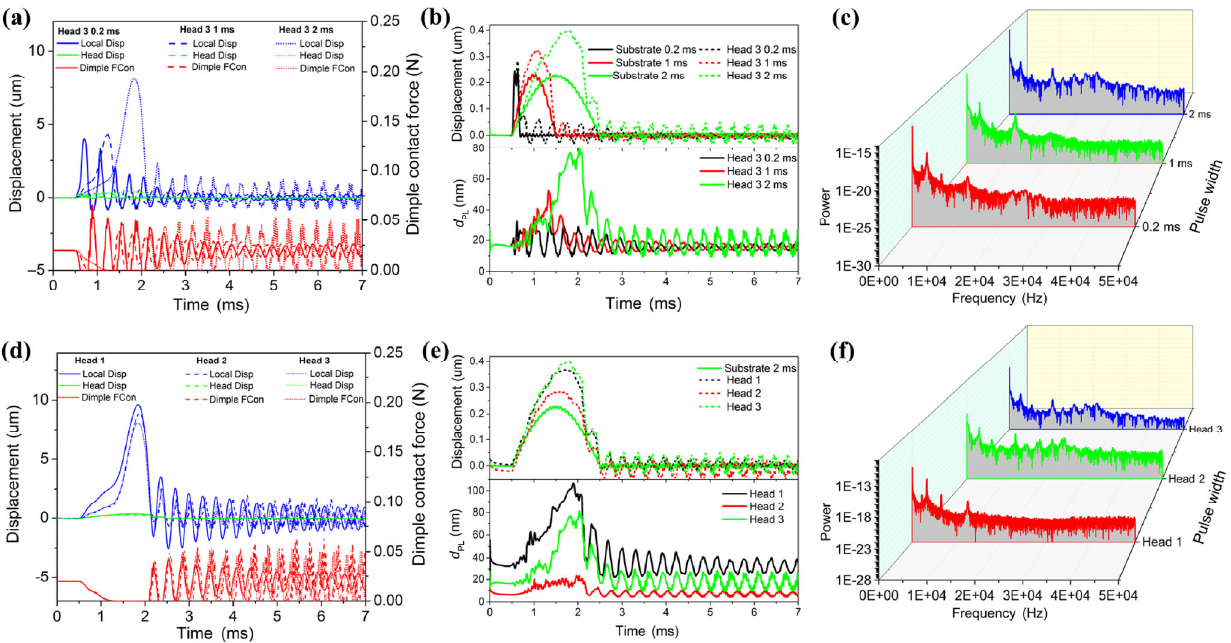
Fig. 7 Positive shock response of the SPAS model: (a) components response, (b) substrate, head, and head at different pulse widths, (d) components response, (e) substrate, head, and ABS